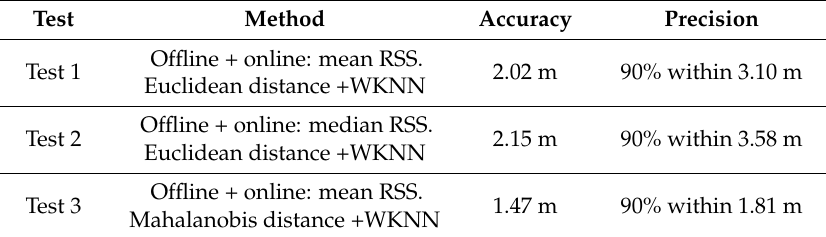
Table 12. Summary of BLE tests presented in this